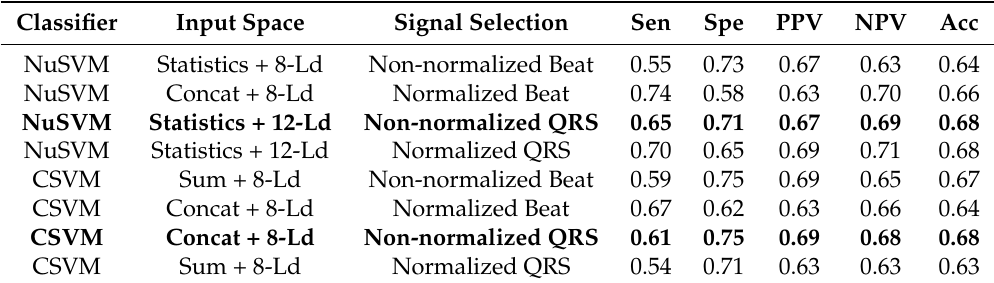
Table 2. Summary of linear classifiers over fibrosis database.